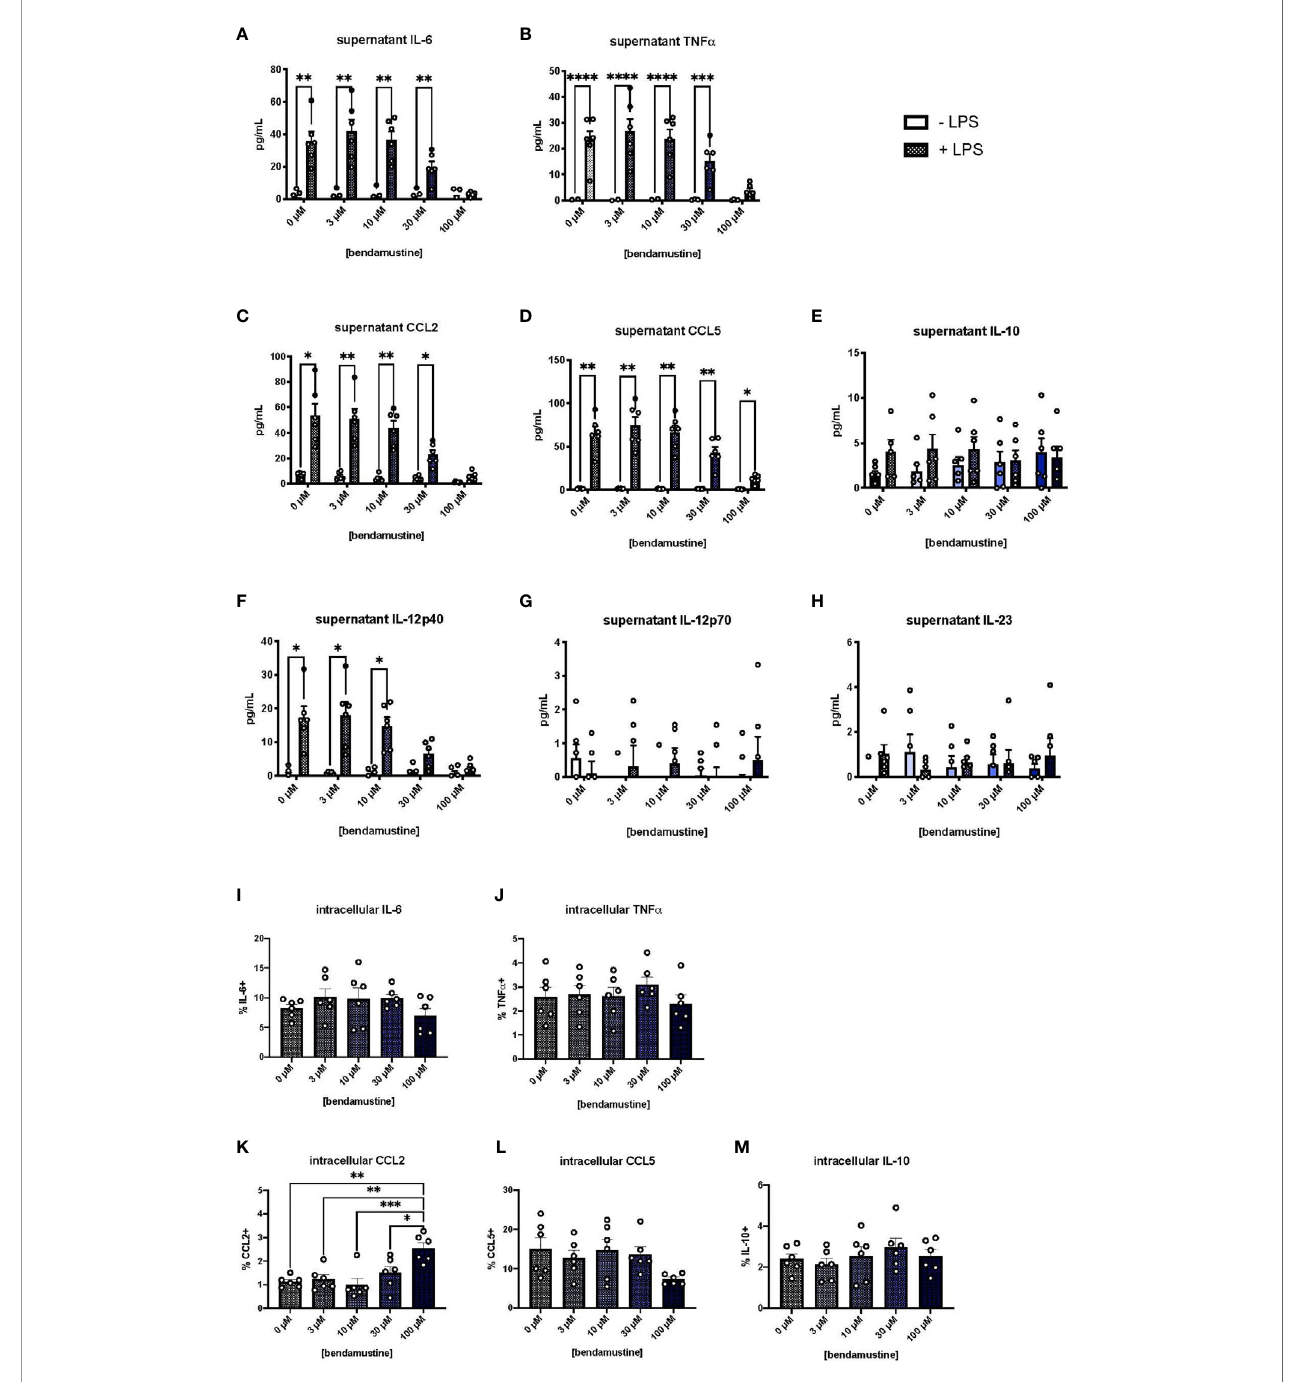
FIGURE 3 | Hindered secretion of pro-in fl ammatory cytokines in response to LPS by murine DCs exposed to BEN. (A-H) BALB/c FL-BMDCs were generated following brief exposure to BEN. With or without 18 hours of LPS stimulation, supernatants were collected for analysis. Data is pooled from 2 independent experiments (n=6). Some values fall below zero, outside of the detectable limits of the assay and outside the axis limits. Mean concentration of (A) IL-6, (B) TNF a , (C) CCL2 (MCP-1), (D) CCL5 (RANTES), (E) IL-10, (F) IL-12p40, (G) IL-12p70, and (H) IL-23 in supernatants is shown with SEM. Two-way ANOVA and S ̌ ida ́ k ’ s multiple comparisons test were used to determine signi fi cance among groups. (I – M) Murine BMDCs were generated following brief exposure to BEN. BMDCs were stimulated with LPS for 3-4 hours and treated with protein transport inhibitors prior to intracellular cytokine staining protocol. Gating was set based on FMO and isotype controls. Data is pooled from 2 independent experiments (n=6). Mean percent of (I) IL-6 + , (J) TNF a + , (K) CCL2 + , (L) CCL5 + , and (M) IL-10 + FL-BMDCs shown with SEM. One-way ANOVA and Dunnett ’ s multiple comparisons test were used to determine signi fi cance among groups. *P < 0.05, **P < 0.01, ***P < 0.001, ****P <